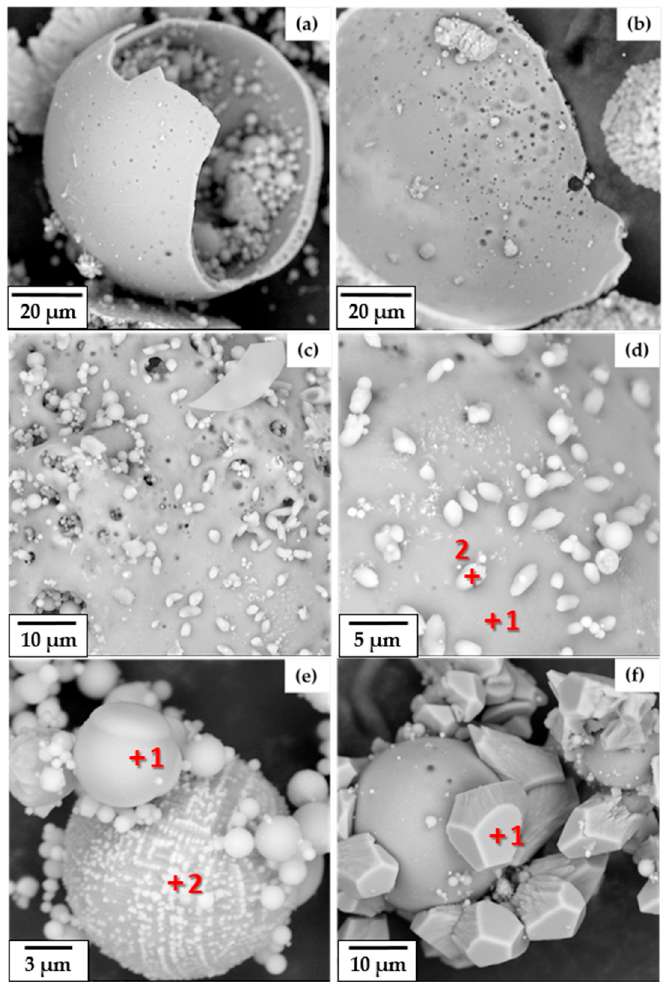
Figure 5. SEM images of cenospheres collected by sink-float method, using a fly ash-to-water ratio of 1:10: ( a , b ) broken particles of cenospheres, ( c , d ) small aggregates on cenosphere surface, ( e ) iron-rich particle, and ( f ) cenosphere particle covered by large aggregates.